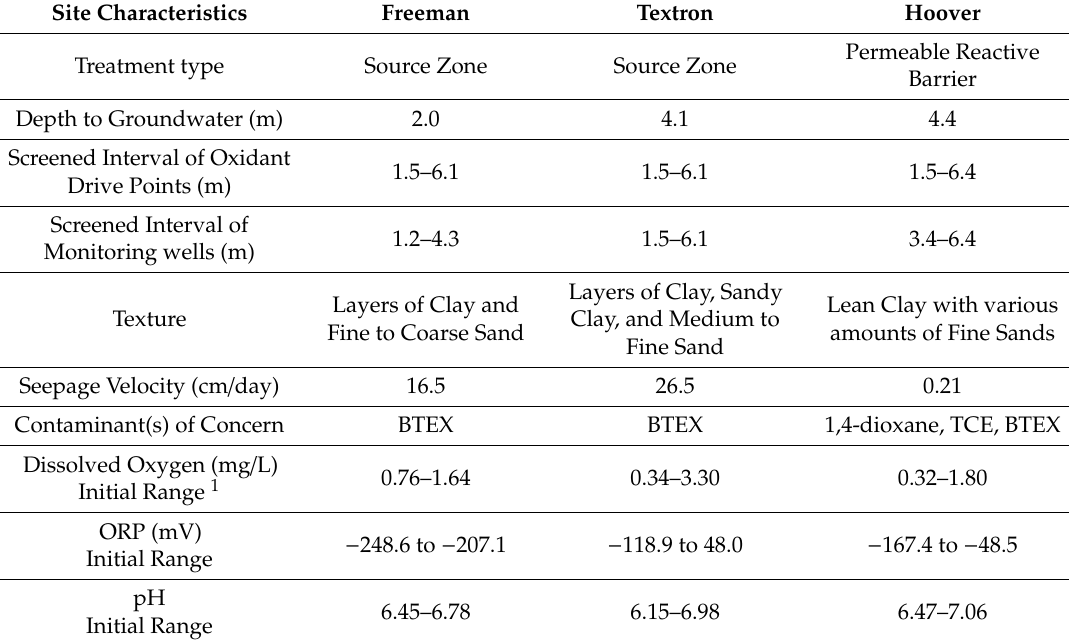
Table 1. General site characteristics of three field sites treated with aerated oxidant candle drive